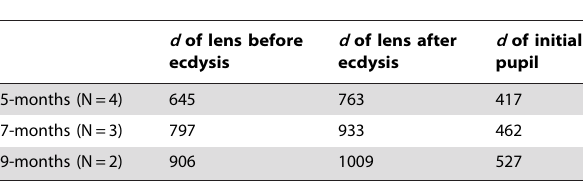
Table 1. Lens and pupil diameters of the PM eyes.